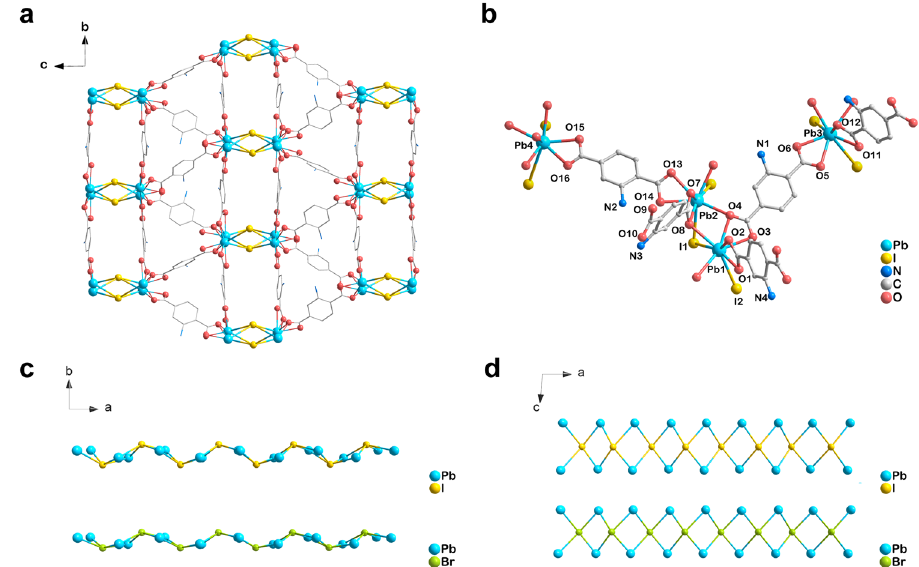
Fig. 1 | X-raycrystallographicviews ofTMOF − 10-NH 2 . a Crystallographicview of TMOF-10-NH 2 (I) along the a -axis. b Crystallographic view of coordination envir- onments for TMOF-10-NH 2 (I). Crystallographic view of a single [Pb 2 X] 3+ (X = Br, I)